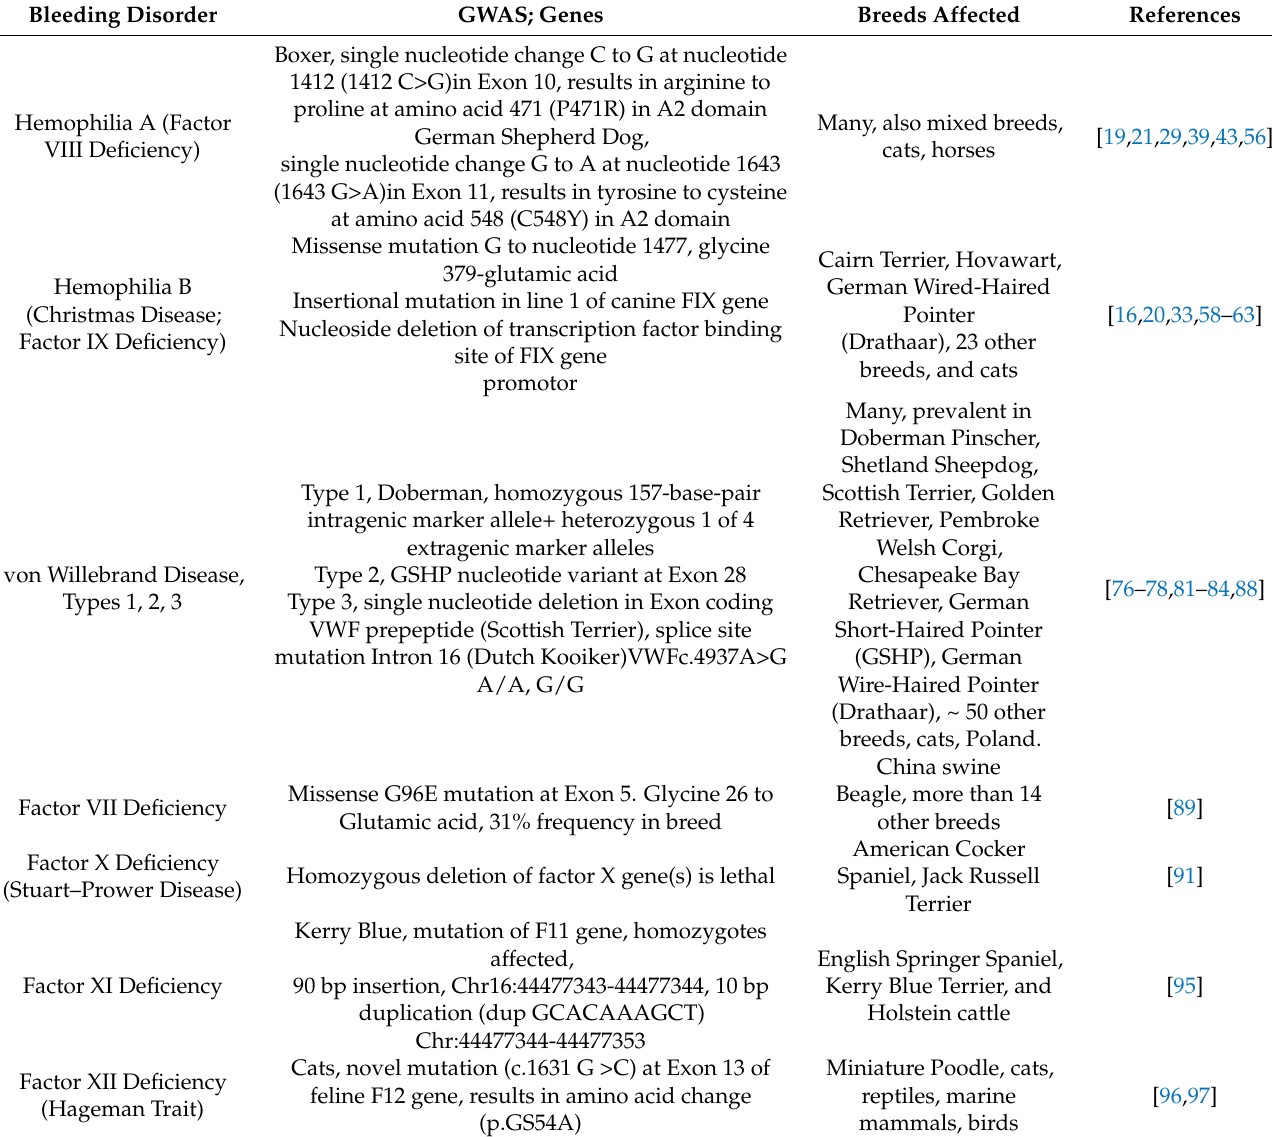
Table 3. Genome Wide Associations (GWAS) for heritable canine bleeding disorder